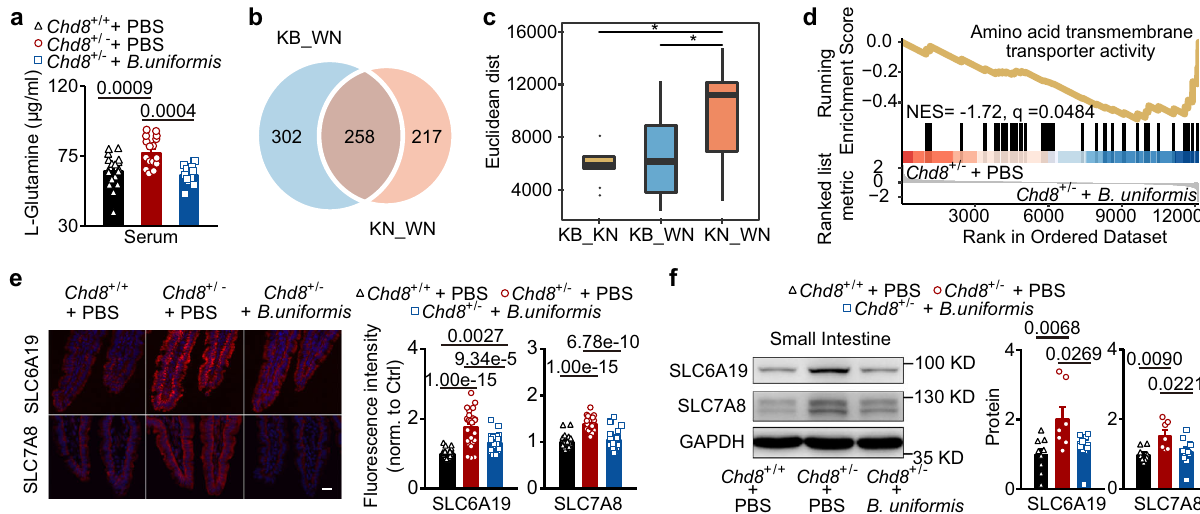
Fig. 5 B. uniformis reduces the expression of intestinal amino acid transporters in the Chd8 + / − mice. a Serum levels of L-glutamine in of 12-week-old mice detected by targeted metabolomics assays. n = 18, 18, and 11 mice, respectively. b – d Bulk RNA-seq analysis of the small intestine of 12-week-old mice. There were n = 3, n = 3, and n = 5 mice in the KN, KB, and WN groups, respectively (WN: Chd8 + / + mice gavaged with PBS; KN: Chd8 + / − mice gavaged with PBS; KB: Chd8 + / − mice gavaged with B. uniformis ). b Venn diagram illustrating the count of DE genes between KN_WN and DE genes between KB_WN. The DE genes were determined under a strict threshold of adjusted P < 0.01 and |log2(cf)| > 0.585. c Euclidean distance of KB_KN ( Chd8 + / − mice gavaged with PBS and Chd8 + / − mice gavaged with B. uniformis ), KB_WN, and KN_WN. The two-tailed Mann – Whitney test was used to calculate the signi fi cance. Box plots were based on 350 data points and showed center line as median, box limits as upper and lower quartiles, whiskers as 1.5 × interquartile range and dots as outliers. d GSEA plot shows the enrichment of the amino acid transmembrane transporter activity pathway in small intestinal cells of the Chd8 + / − mice gavaged with PBS compared to the Chd8 + / − mice gavaged with B. uniformis . e Immuno fl uorescence staining of SLC6A19 and SLC7A8 in the ileum of the mice at week 12. Scale bar, 20 μ m. n = 3 mice per group. Each symbol represents one image; seven to nine images per mouse. n = 28, 26, and 21 symbols, respectively. f Western blotting analysis of the SLC6A19 and SLC7A8 protein levels in the small intestine of the mice at week 12. n = 9, 7, and 11 mice, respectively. Quantitative data are shown as the mean ± SEM. Statistical analysis was determined by one-way ANOVA with two-tailed Tukey ’ s multiple comparison test ( a , e , f ). Signi fi cance was indicated by P